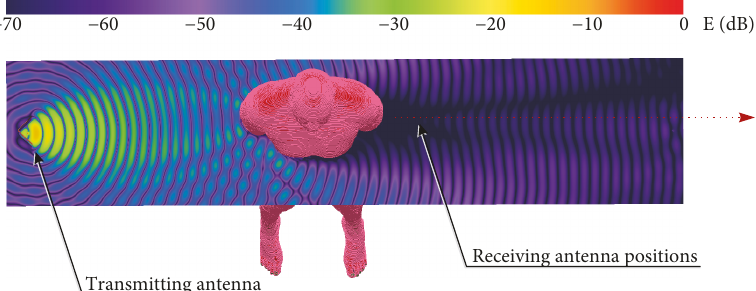
Figure 8: Simulation results for electric fi eld strength obtained using FDTD — body orientation